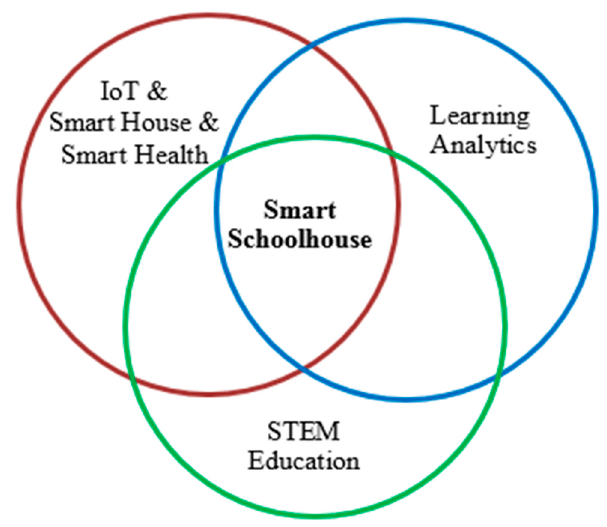
Figure 1. A Smart Schoolhouse—common core of Learning Analytics, STEM (Science, Technology, Engineering, and Mathematics) education and IoT (Internet of Things) [20].